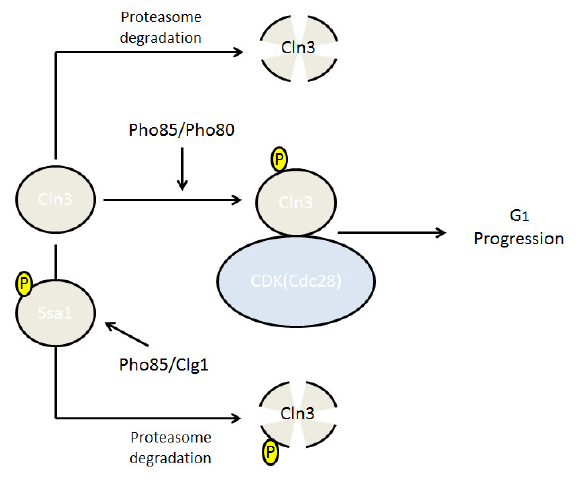
FIGURE 3: Pho85 involvement in cell cycle progression. The